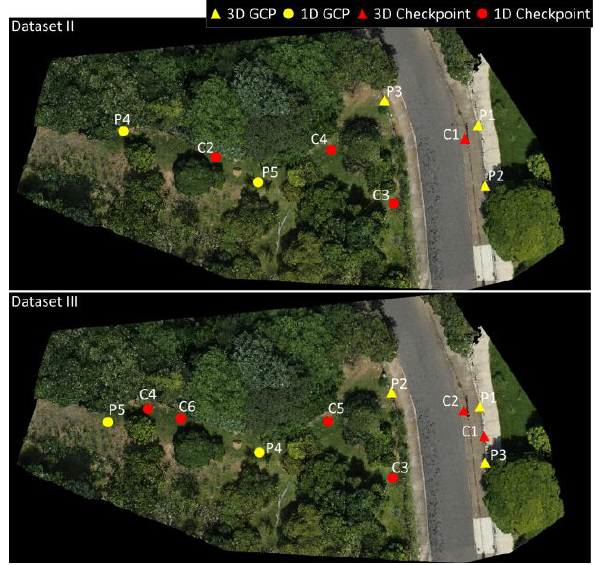
Figure 7. Top view of the generated dense point cloud that covers the test area and the localisation of GCPs (in yellow) and checkpoints (in red) used in the georeferencing process of datasets II and III.